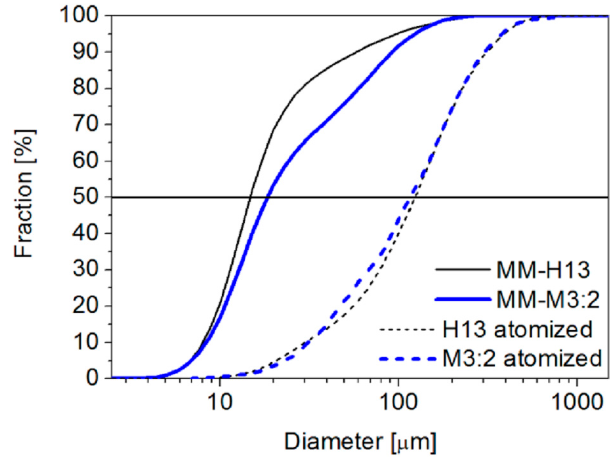
Figure 2. Particle size distribution of base as-atomized and mechanically milled powders.